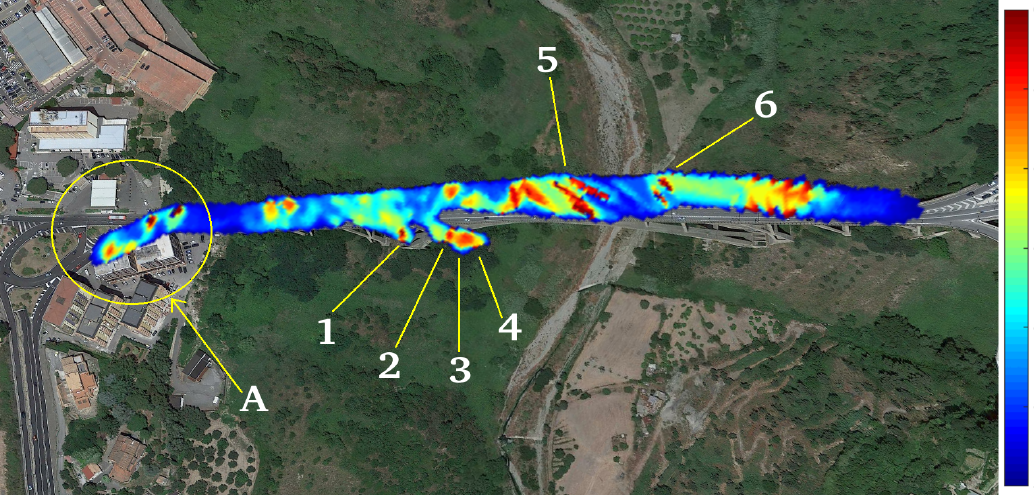
Figure 17. “Bisantis” bridge vibration